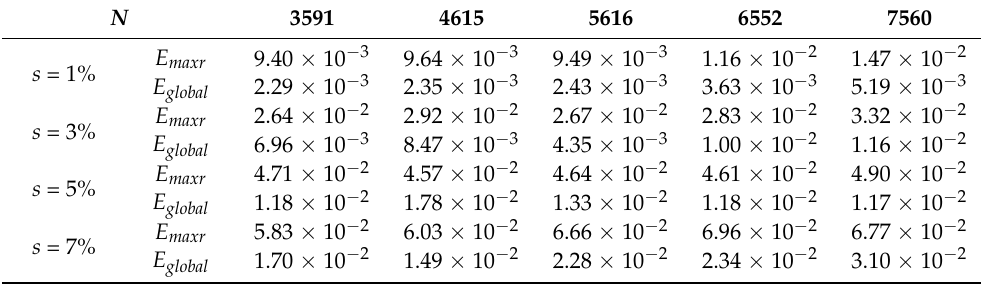
Table 3. The numerical errors of different number of total nodes.